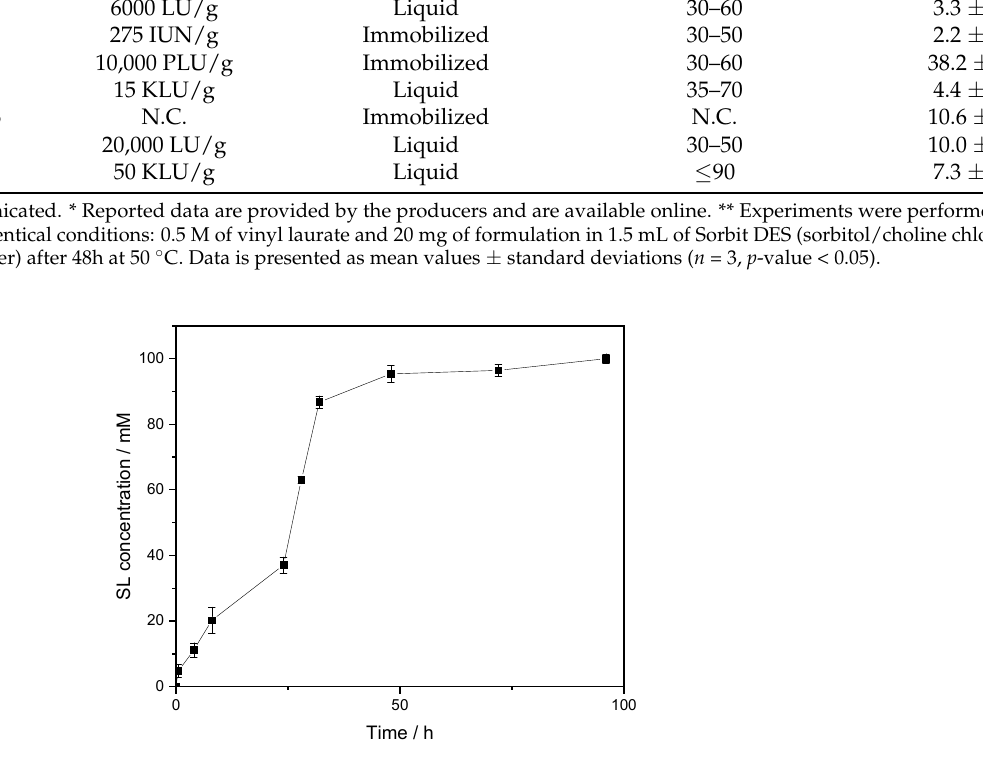
Table 2. Titer (g/L) of SL obtained after 48 h with commercially available enzyme formulations.